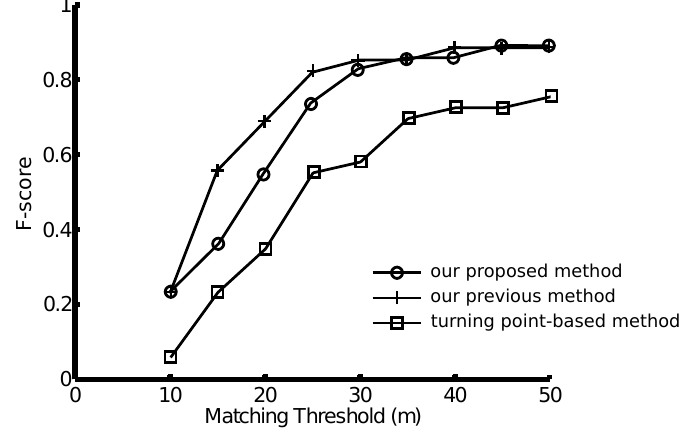
Figure 13. Accuracy